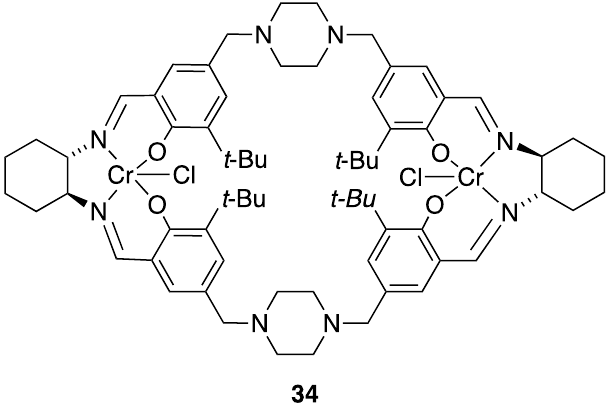
Figure 14. Macrocyclic Cr–salen complex 34 .